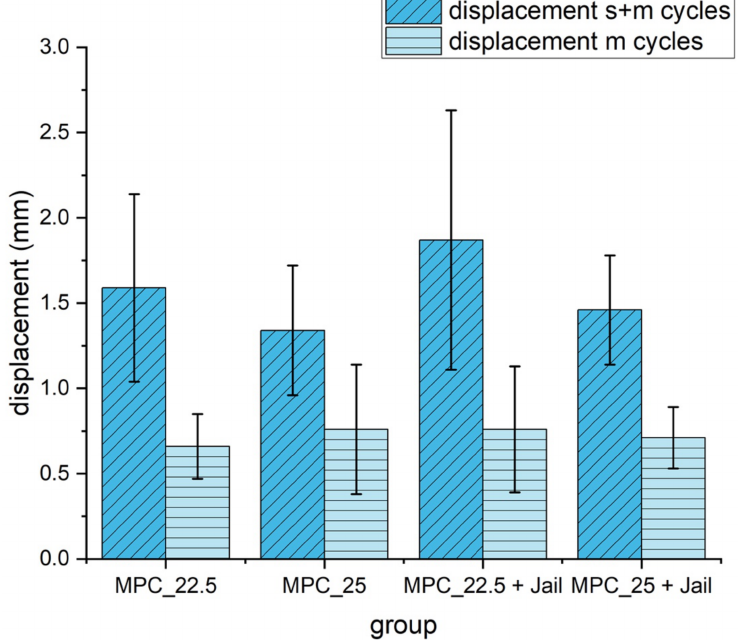
Figure 13. Displacement of the reduced and fixed fractures with MPC and MPC plus screws in the jail technique under cyclic loading of 10 settling cycles (20–125 N) and 3000 measuring cycles (20–250 N). Differences between displayed groups were not statistically significant ( p = 0.17). s+m cycles = settling and measuring cycles; m = measuring cycles